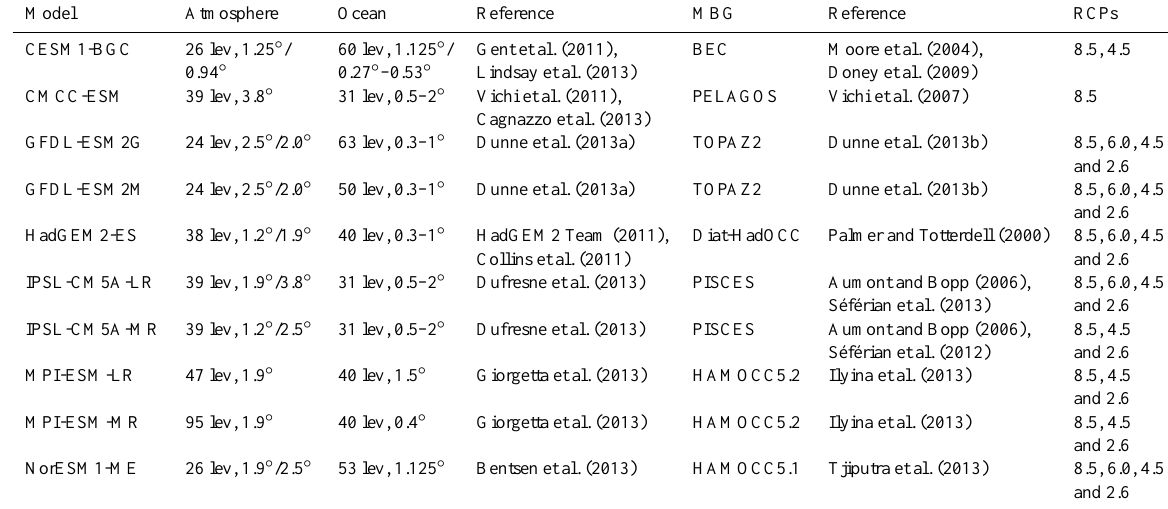
Table 1a. A brief description of the models used in this study, indicating atmospheric and oceanic resolution (lev is the number of levels on the vertical, and then the horizontal resolution is indicated in degrees), the marine biogeochemical component included in the ESM, and the different RCP scenarios performed and used in this